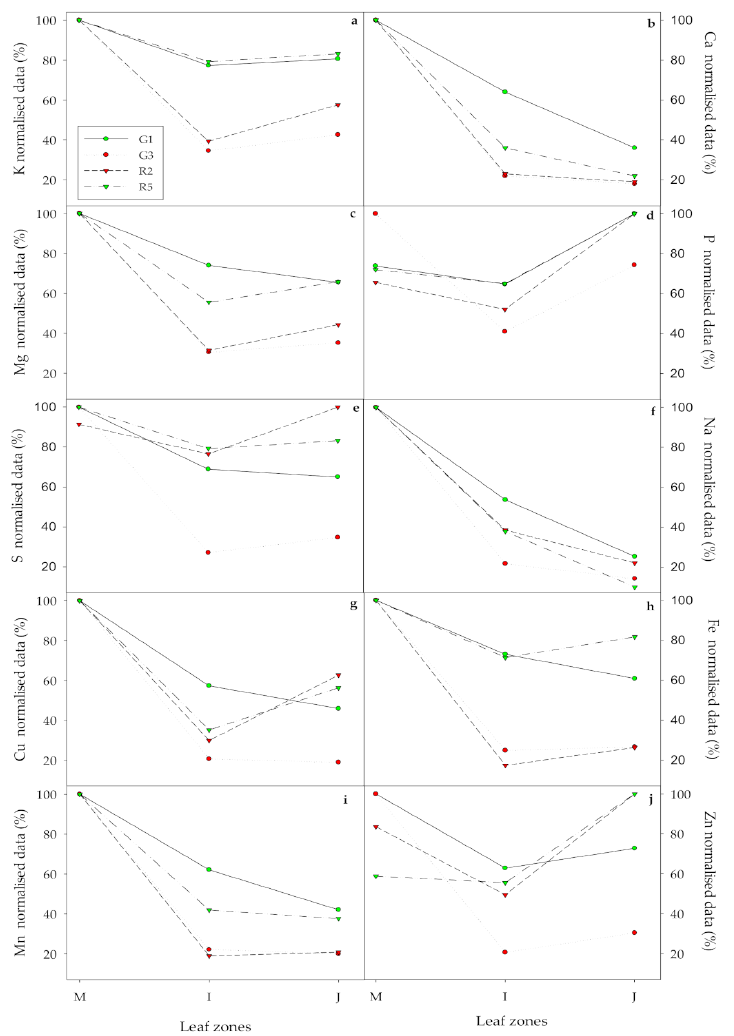
Figure 7. Nutrient analysis of the studied macronutrients in different leaves (M, mature; I, interme- diate; J, juvenile). Only the most divergent genotypes for tipburn scoring and tipburn incidence for GOAK (G1 and G3) and ROAK (R2 and R5) cultivars are shown. The nutrients analyzed were ( a ) Potassium (K), ( b ) Calcium (Ca), ( c ) Magnesium (Mg), ( d ) Phosphorus (P), ( e ) Sulphur (S), ( f ) Sodium (Na), ( g ) Copper (Cu), ( h ) Iron (Fe), ( i ) Manganese (Mn) and ( j ) Zinc (Zn). Data are normalized as regards the leaf with the highest amount for a given